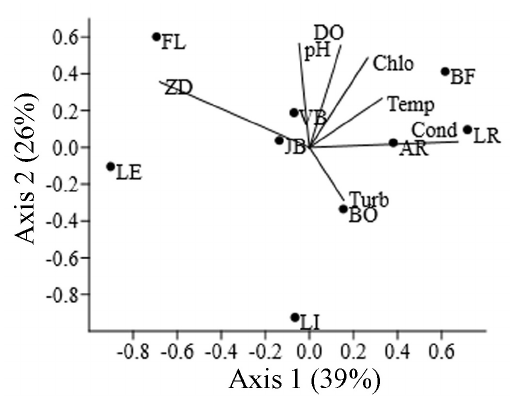
Figure 2. PCA plot of abiotic variables (Temp = water temperature, Cond = electrical conductivity, DO = dissolved oxygen, turb = turbidity), chlorophyll a (Chlo) and Zygnematophyceae density (ZD) in nine urban eutrophic ponds from Goiânia, GO (see codes at Table 1). Table 2. Mean and standard deviations (n = 3) values for limnological variables in nine urban eutrophic ponds from Goiânia, GO (see codes at Table 1). Water temperature Electrical Dissolved oxygen Ponds pH (°C) conductivity (µS cm -1 ) (mg L -1